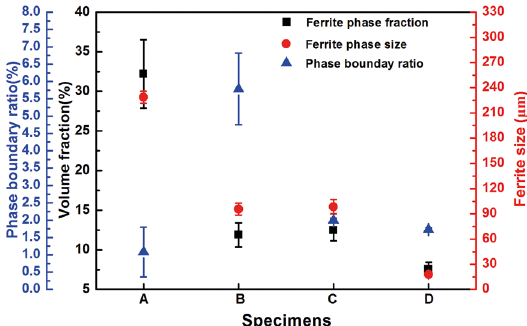
Figure 3. Four Z3CN20.09M primary coolant pipe specimens with different ferrite contents and sizes and austenite/ferrite phase